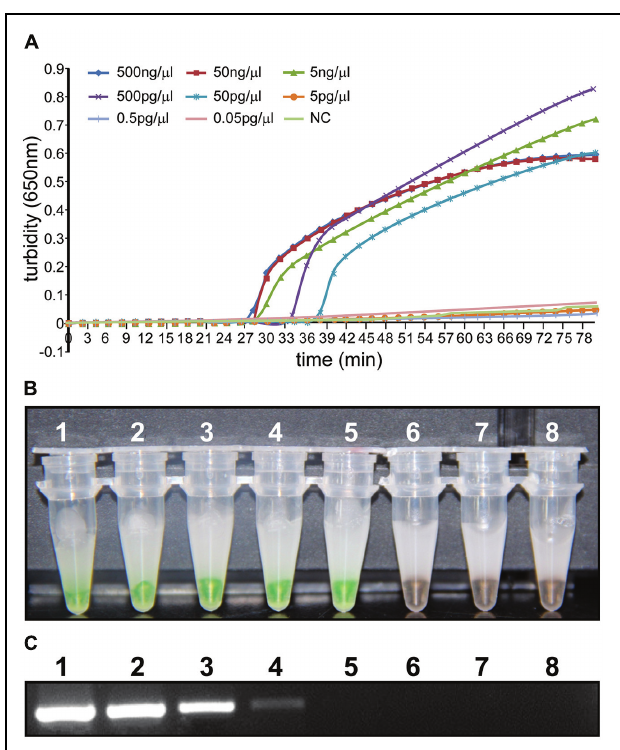
FIGURE 4 | Sensitivity of the LAMP reaction and PCR for detection of the bla OXA − 51 − like gene. Genomic DNA was diluted in a set of serial 10-fold dilutions. Both LAMP reactions (A,B) and PCR (C) were performed in duplicate for each dilution. Tubes and lanes: 1: 500 ng/ μ l, 2: 50 ng/ μ l, 3: 5 ng/ μ l, 4: 500 pg/ μ l, 5: 50 pg/ μ l, 6: 5 pg/ μ l, 7: 0.5 pg/ μ l, 8: 0.05 pg/ μ l. (A) Turbidity was monitored using a Loopamp real-time turbidimeter by measuring the absorbance at 650 nm every 6 s. (B) The direct visual method for the detection of LAMP. One microliter of fluorescent detection reagent was added to 25 μ l of LAMP reaction mixture before the LAMP reactions were initiated. (C) PCR products were separated by 1% agarose gel electrophoresis and stained with ethidium